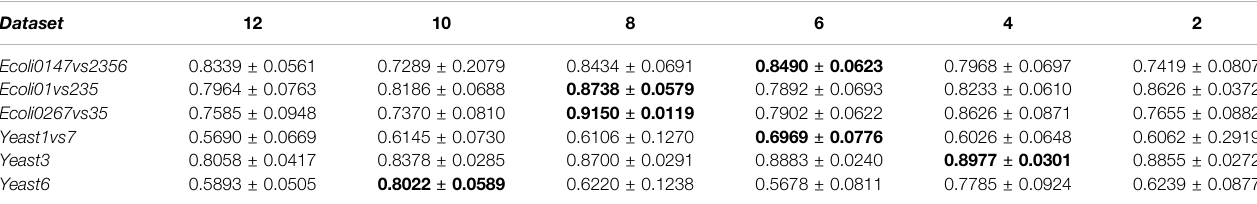
The bold values mean the best